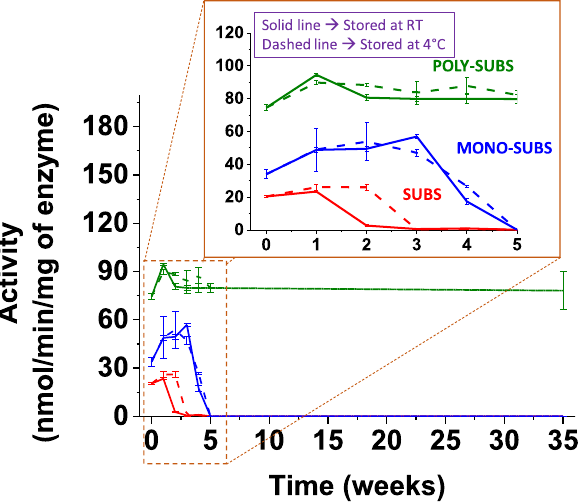
Figure 5. Stability study of three different substrates, i.e., SUBS, MONO-SUBS, and POLY-SUBS, stored at 4 °C and room temperature for 35